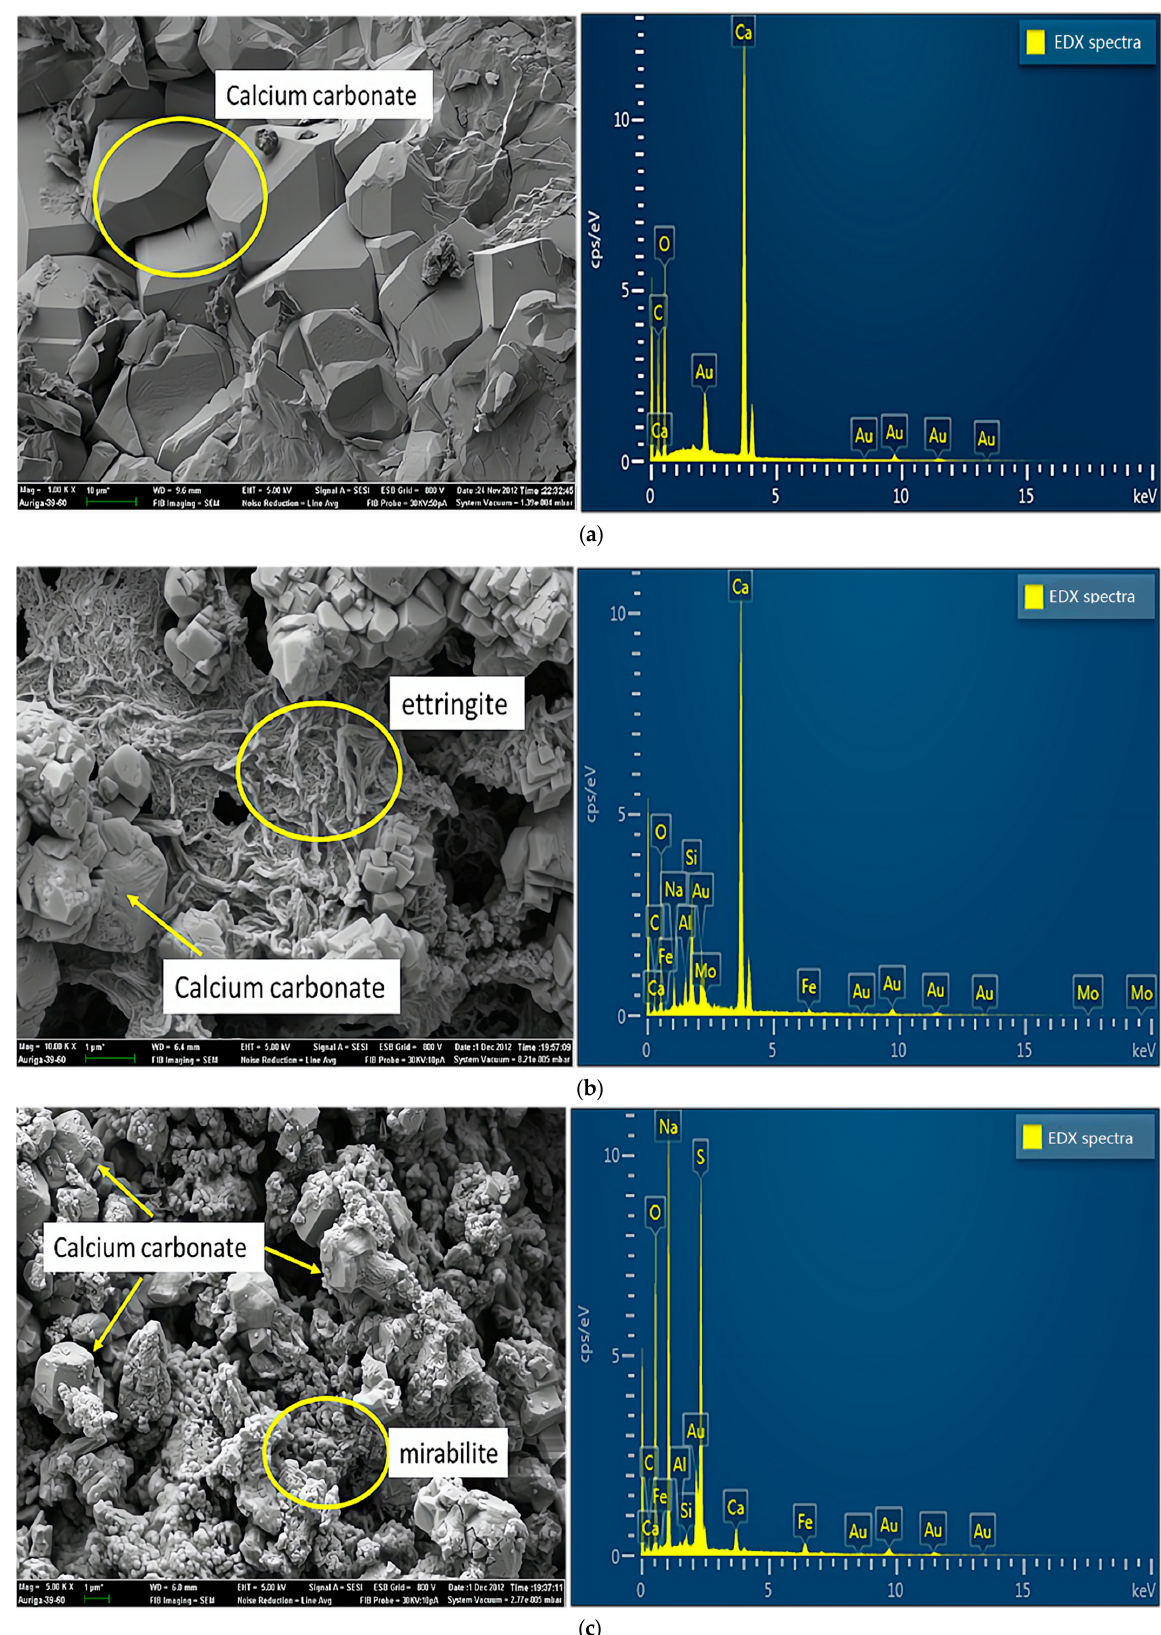
Figure 7. SEM and EDX spectra of samples damaged by uniaxial compression: ( a ) sample without sulfate solution; ( b ) sample with sulfate attack at 2% concentration; ( c ) samples with sulfate attack at 10% concentration.